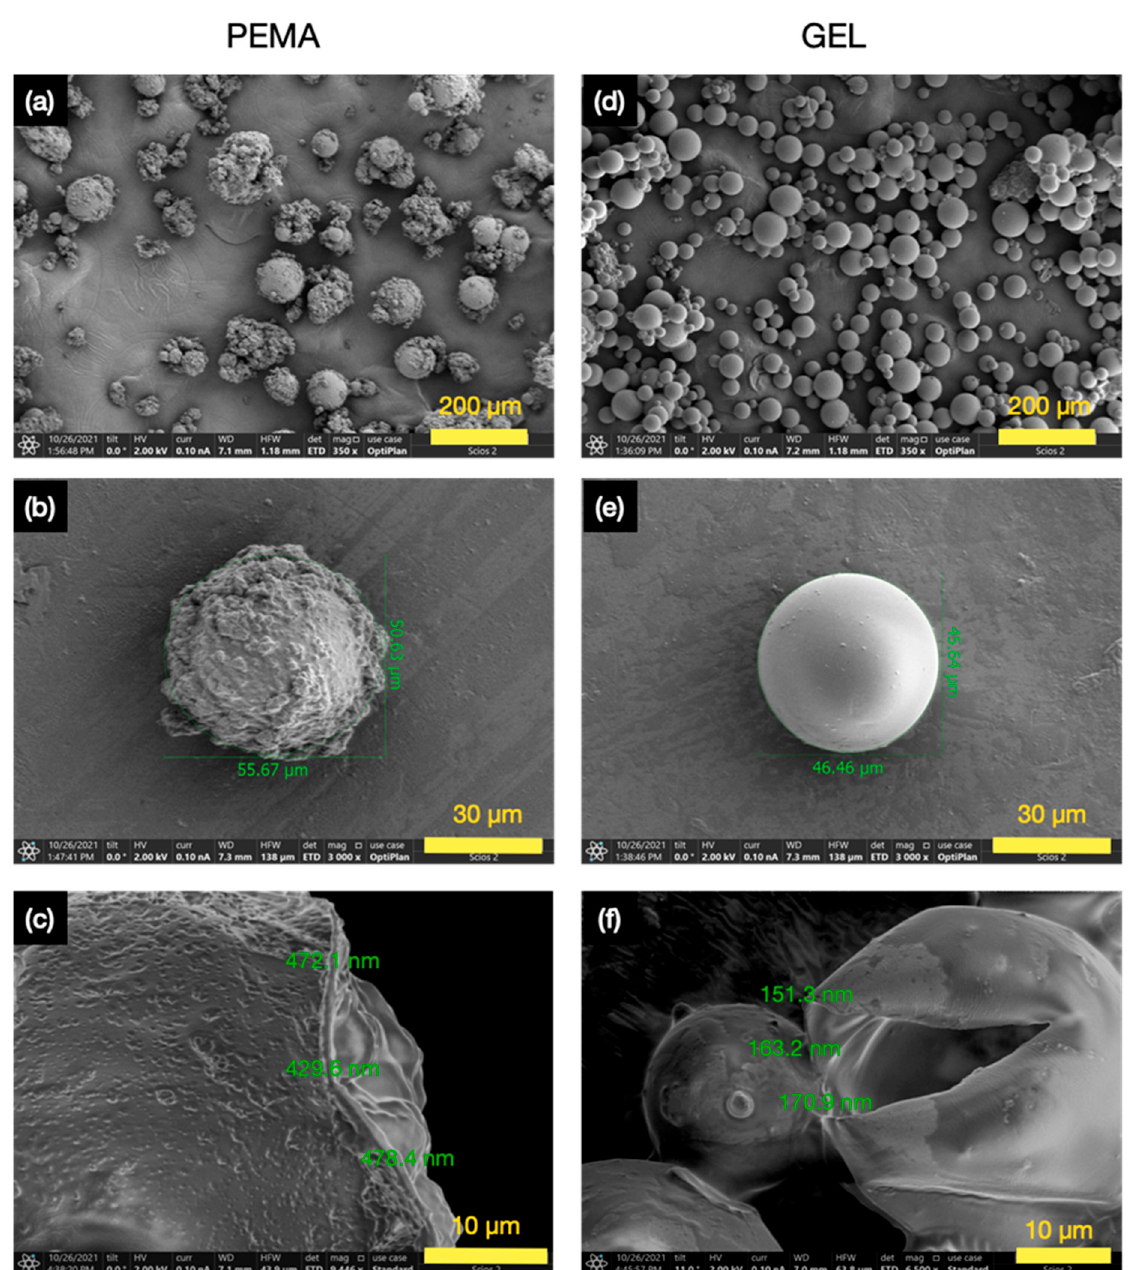
Figure 5. SEM micrographs for the ( a ) overall morphology for PEMA microcapsules, ( b ) individually isolated PEMA microcapsule, ( c ) shell thickness of a PEMA microcapsule, ( d ) overall morphol- ogy for GEL microcapsules, ( e ) individually isolated GEL microcapsule, ( f ) shell thickness of a GEL microcapsule.